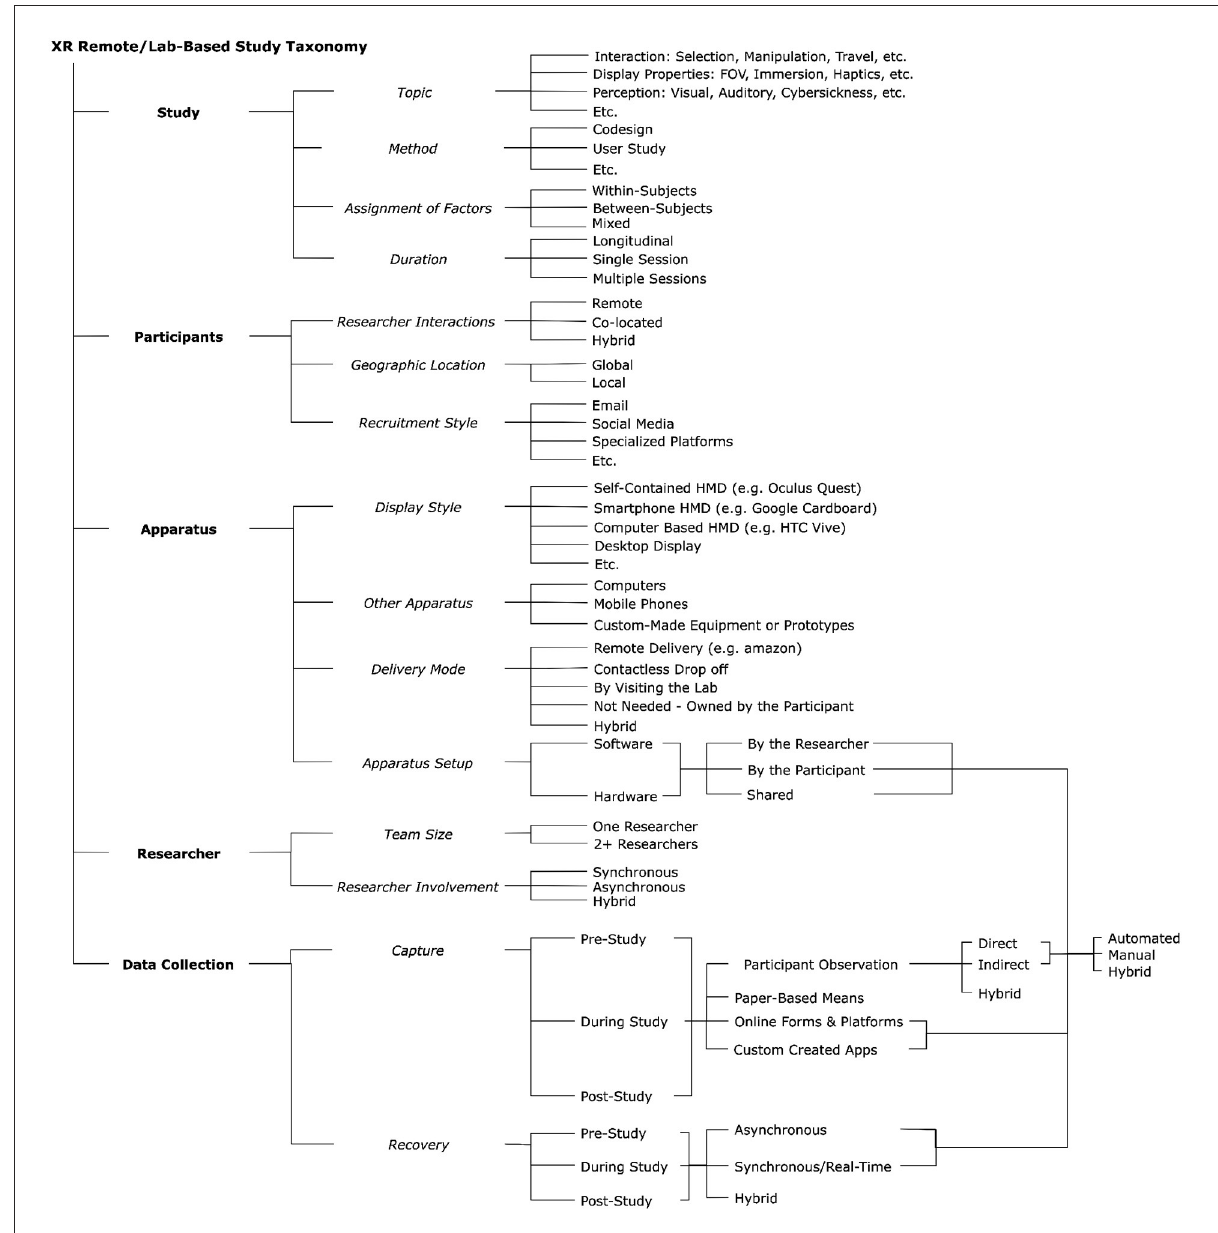
FIGURE12 Proposed XR remote study